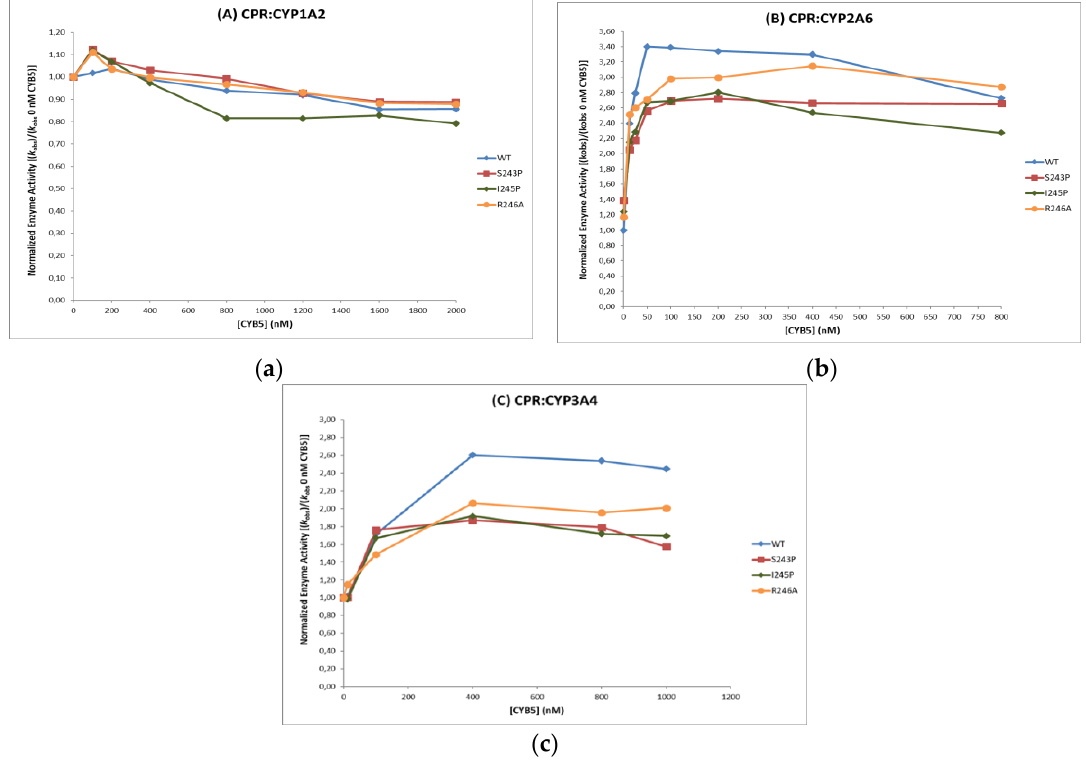
Figure 4. Effect of CYB5 concentration on maximum reaction velocities of CYP1A2 ( A ), 2A6 ( B ) and 3A4 ( C ) when sustained by WT CPR and the three hinge mutants. Activities were normalized to the one without CYB5 for each CPR mutant in comparison to WT.